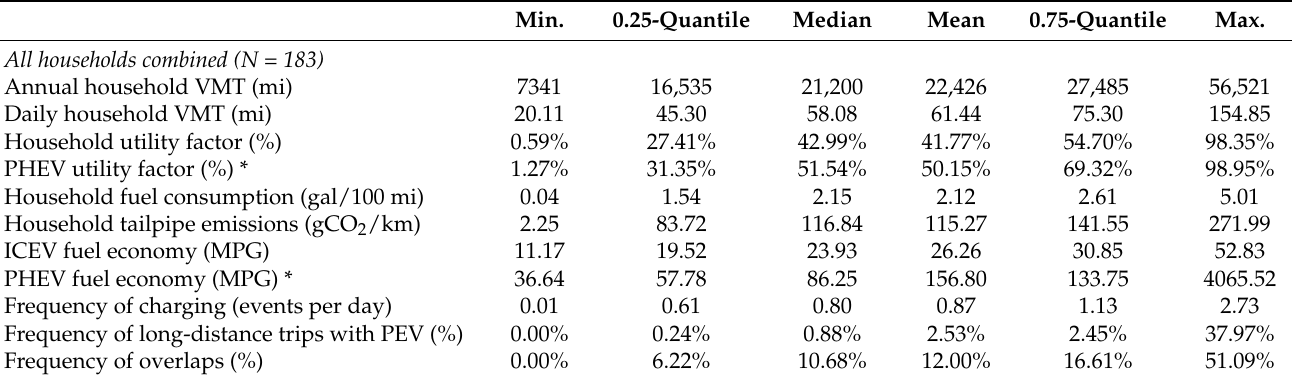
Table 2. Summary statistics for two-car households.